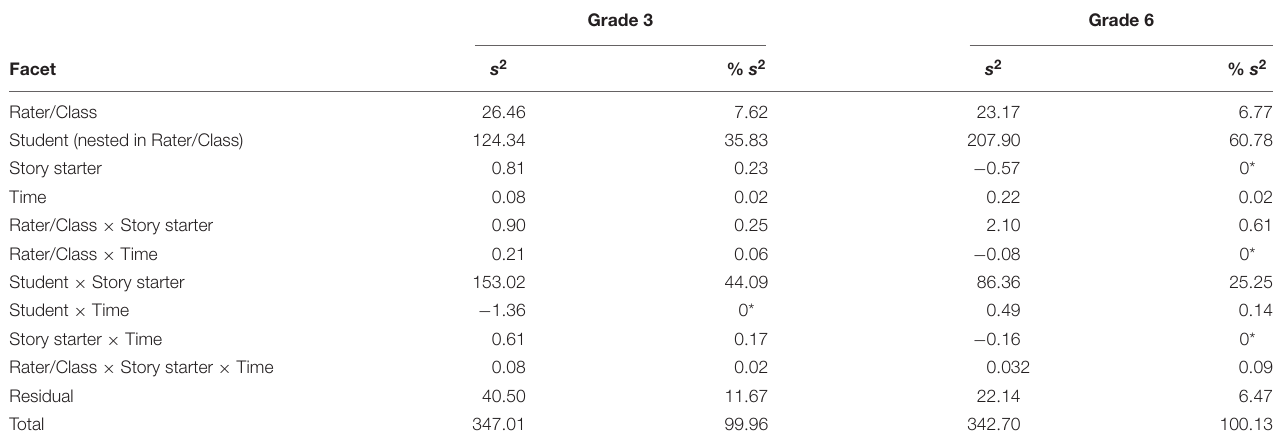
TABLE 3 | Results of the G-study for %CWS with time as a